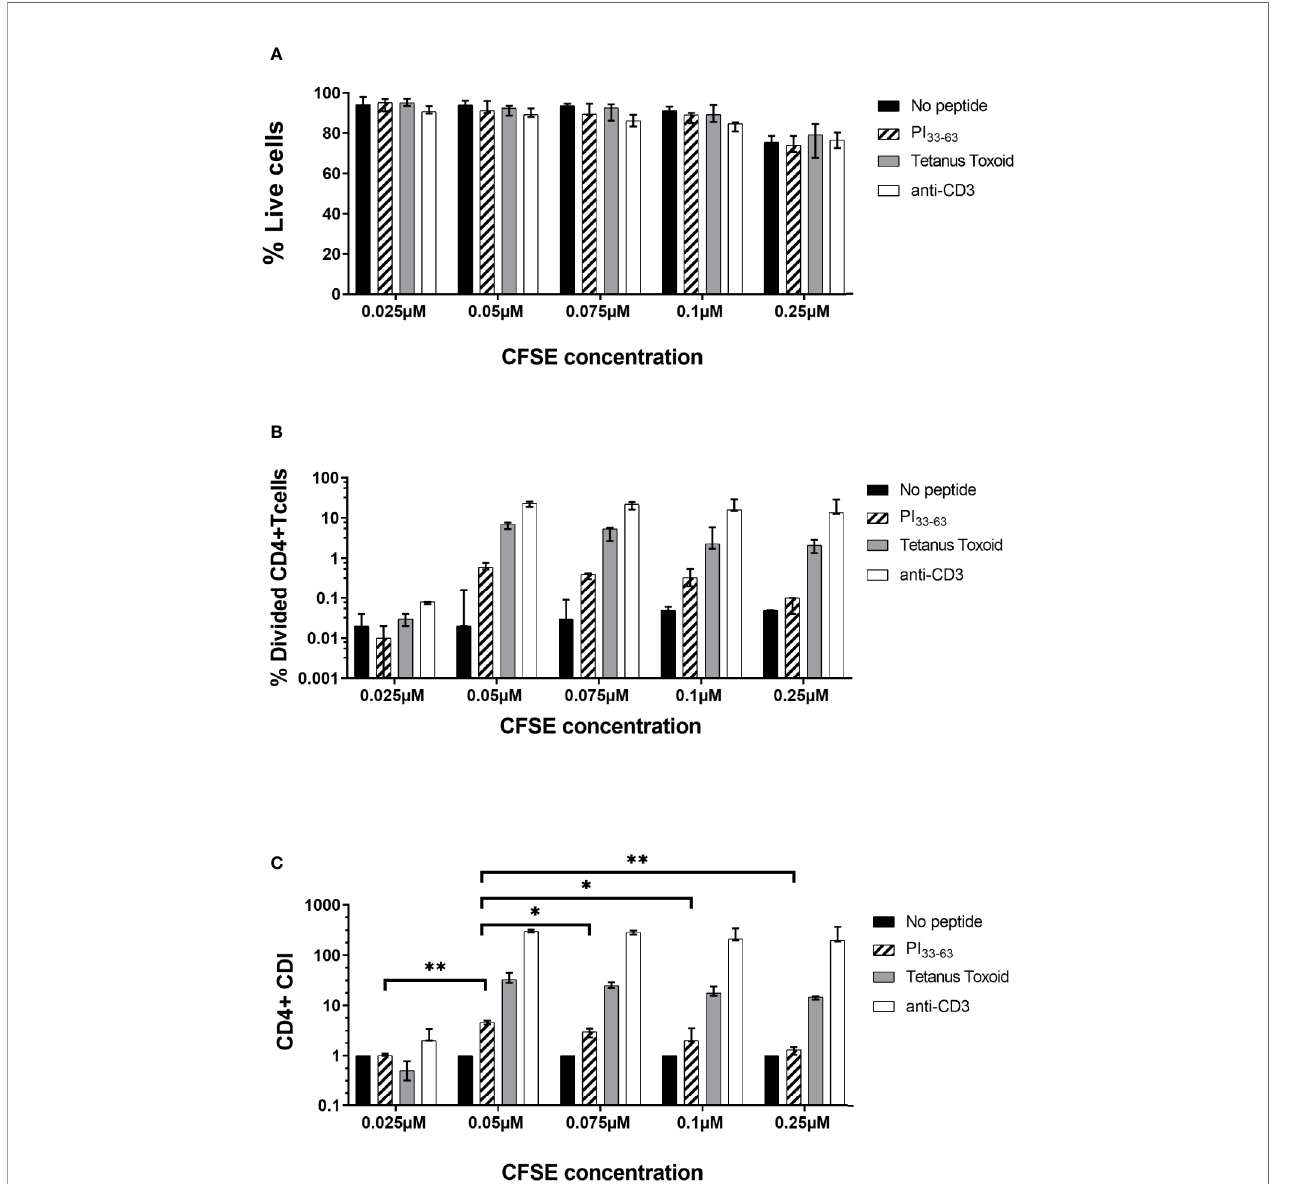
FIGURE 2 | Titration of CFSE concentration. Freshly isolated PBMC from three patients were stained with different concentrations of CFSE as shown and incubated with PI 33-63 (10 µM), tetanus toxoid (10 Lf/ml) or anti-CD3 antibodies (0.1 µg/ml) for 7 days. (A) Percentage of live cells after 7 days of incubation. (B) Percentage of Divided CD4 + T-cells. (C) CD4 + T-cell Division Index. Median value and range from three technical replicates are shown. CDI for each CFSE concentration was compared: *p < 0.05, **p < 0.01, paired t